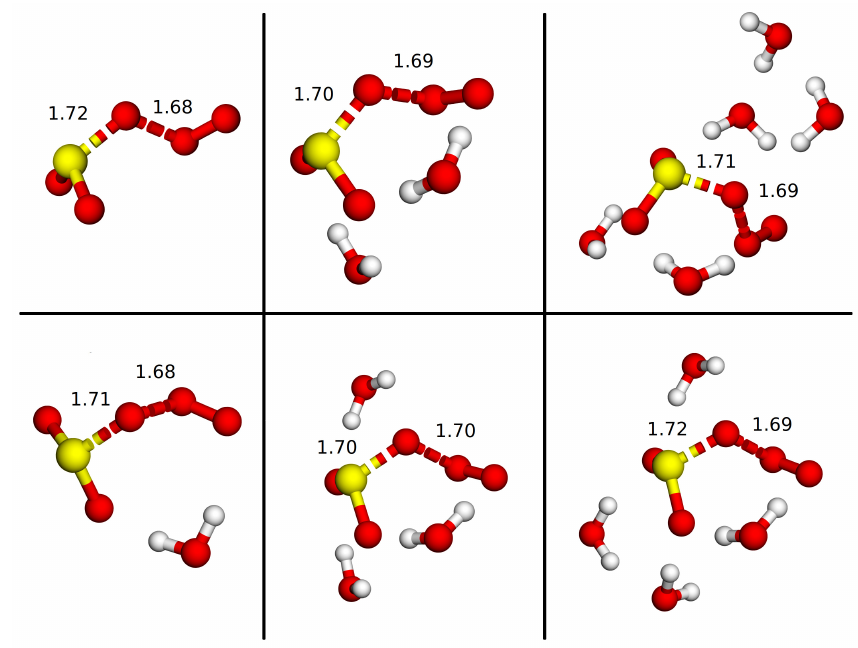
Fig. 6. Structures of the class of transition state complexes characterized by high entropy. These are denoted “sparse” due to the sparse water structures. The water free structure is again included for completeness. The dashed bonds indicate the bonds which are active in the reaction. Bond lengths are given in ˚A. Sulfur (yellow), oxygen (red), hydrogen